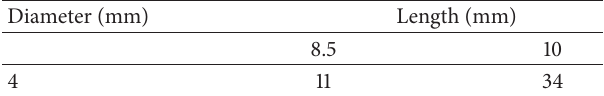
Table 2: Implant dimension ( 𝑛 = 45